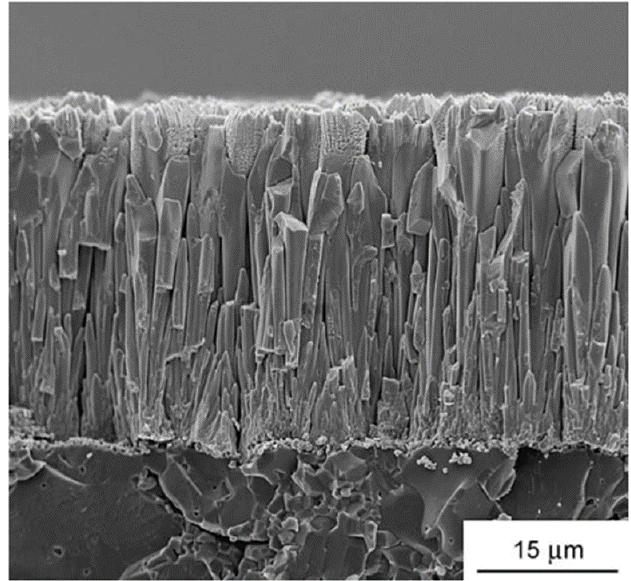
Figure 12. Microstructure of TBC manufactured by chemical vapor deposition (CVD) process (reproduced with permission from [66], Elsevier, 2005).